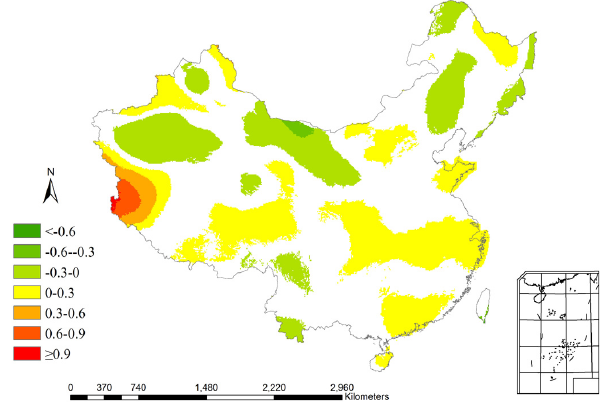
Fig. 5. Spatial distribution of the changing rate of annual diffuse radiation in China from 1981 to 2010 (white areas denote that there are no statistically significant trends, α = 0 . 05. Unit: % per